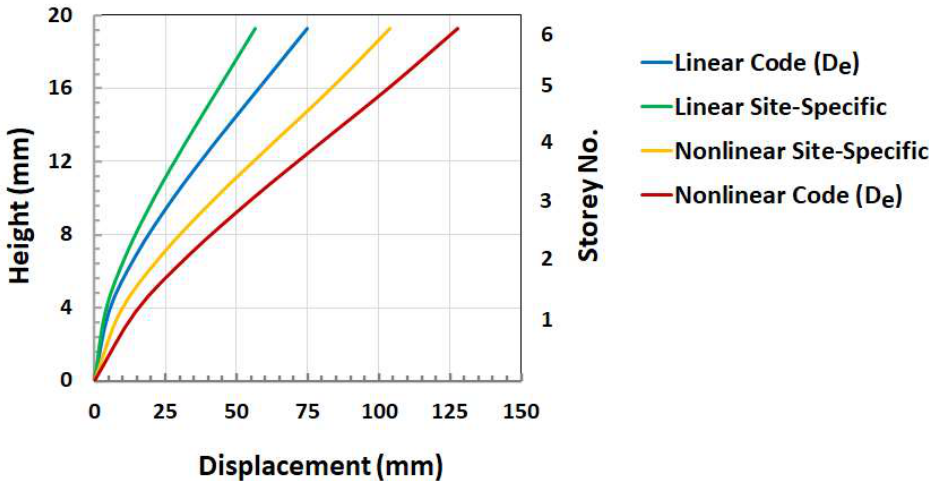
Figure 12. Comparison of the floor displacements in modified CSB 1 due to linear and nonlinear site-specific and code response spectrum analysis.